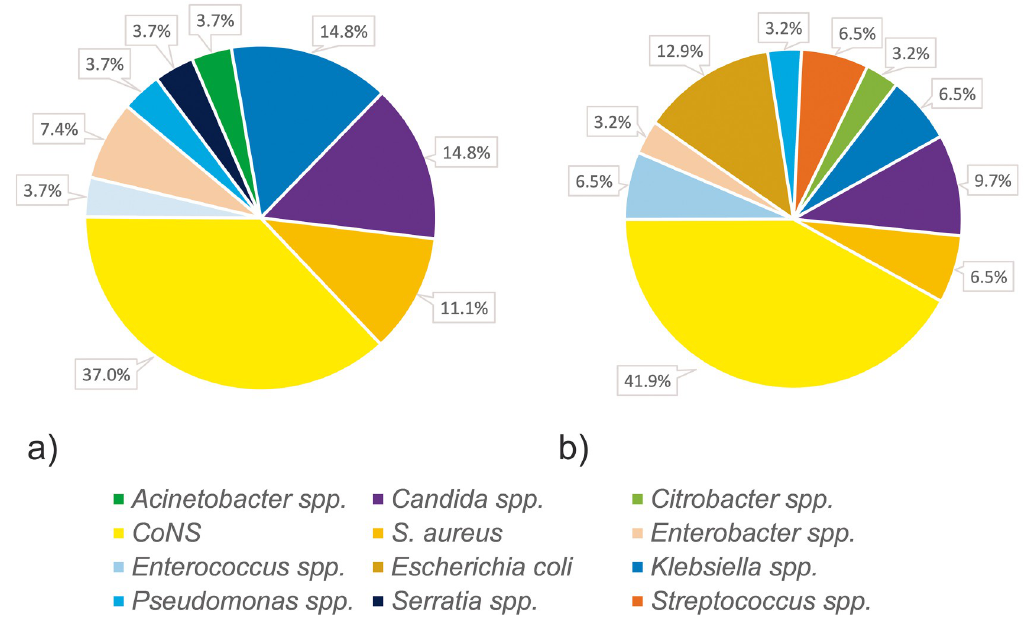
Fig 4. Subgroup analysis of catheter infections (CI). Group 2.1: CI with matching isolates from blood cultures and the port catheter tip (a). Group 2.2: CI with positive blood culture results and negative culture of the port catheter tip (b). Coagulase- negative staphylococci–CoNS,